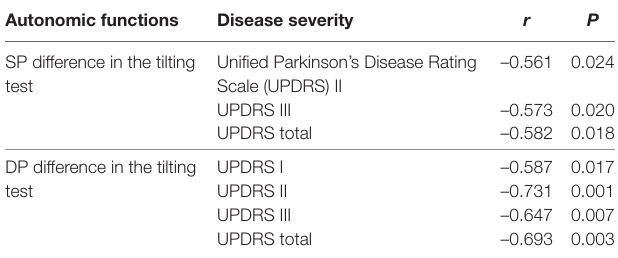
TaBle 4 | Correlation between autonomic function and disease severities. TaBle 3 | Analysis of correlation between autonomic functions and group